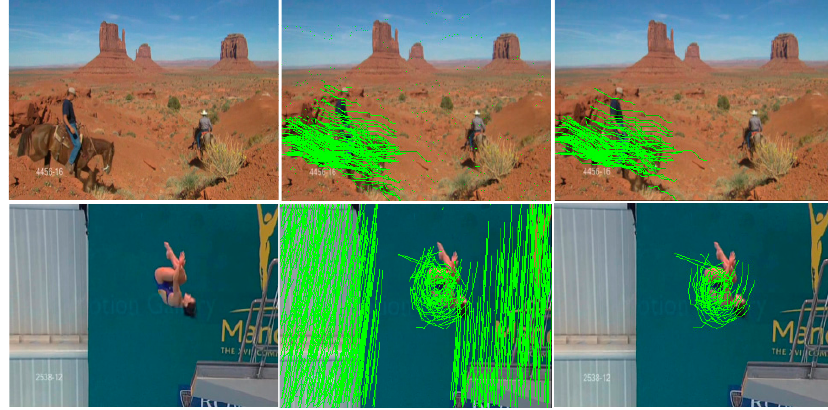
Figure 2. Comparison of traditional dense trajectory and foreground trajectory extraction in this paper.